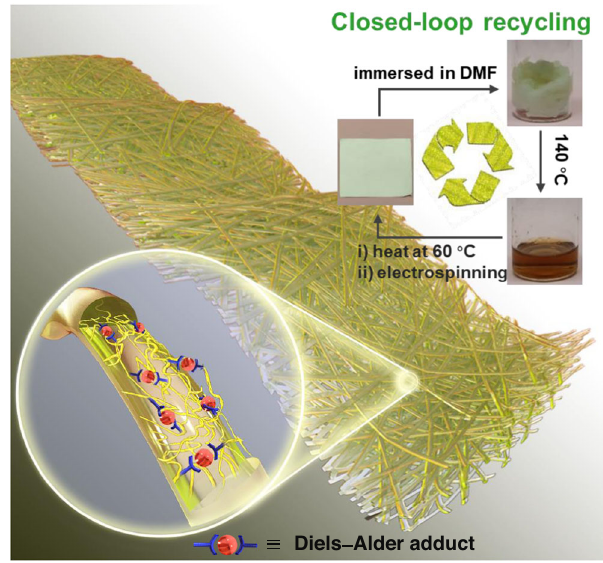
Fig. 1 | Overview of DCCNFs. Schematic representation of the DCCNFs with superior features and closed-loop